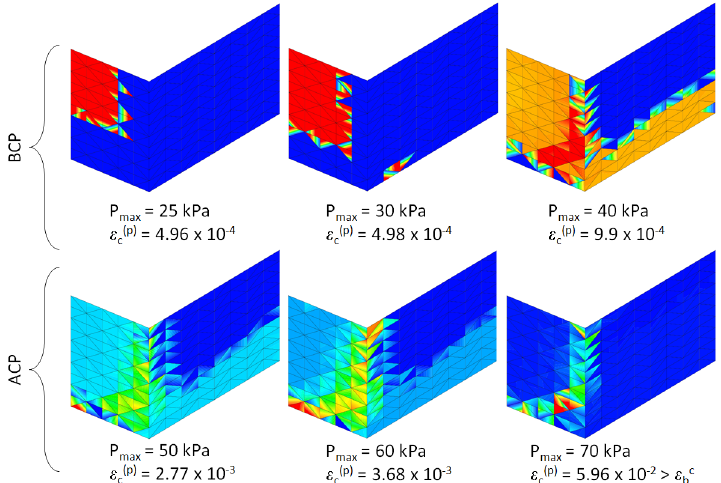
) reached inside the concrete for several loading pressures ( P max ). BCP b has or not exceeded the strain b is exceeded, the concrete is highly damaged and announces the b